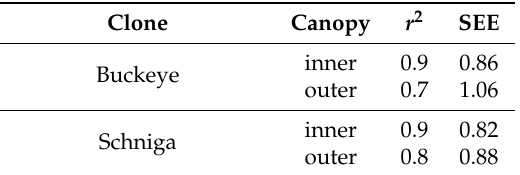
Table A7. Summary of linear regression for predicting FFF based on IAD measurements for season 2015. The regression was significant at p > 0.005.